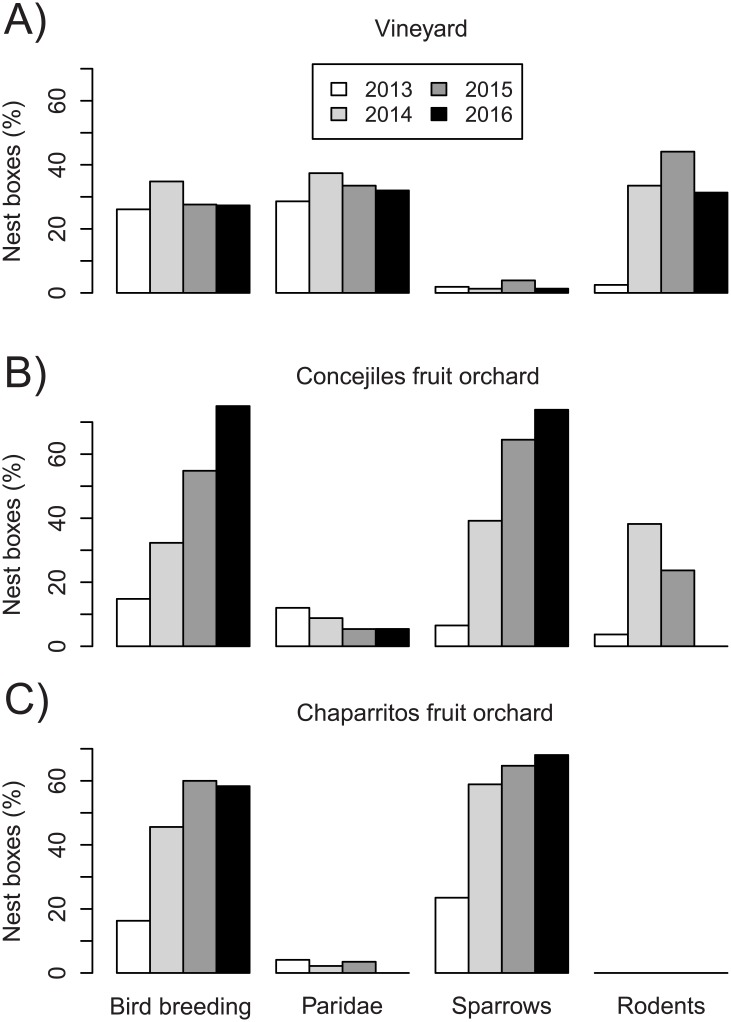
Relevant categories of use for nest boxes installed in the (A) Abadía Retuerta vineyard, (B) Concejiles fruit orchard and (C) Chaparrito fruit orchard, across the four years of study.Bird breeding refers to verified hatched eggs or recruited fledglings (categories 4–5 of nest box use, see Methods). Bars for insectivorous birds (Paridae) and sparrows refer to categories 2 (finished nest) to 5 (recruited fledglings). Nearly all observations contributing to the “Rodents” bar refer to Garden dormouse (category 6).